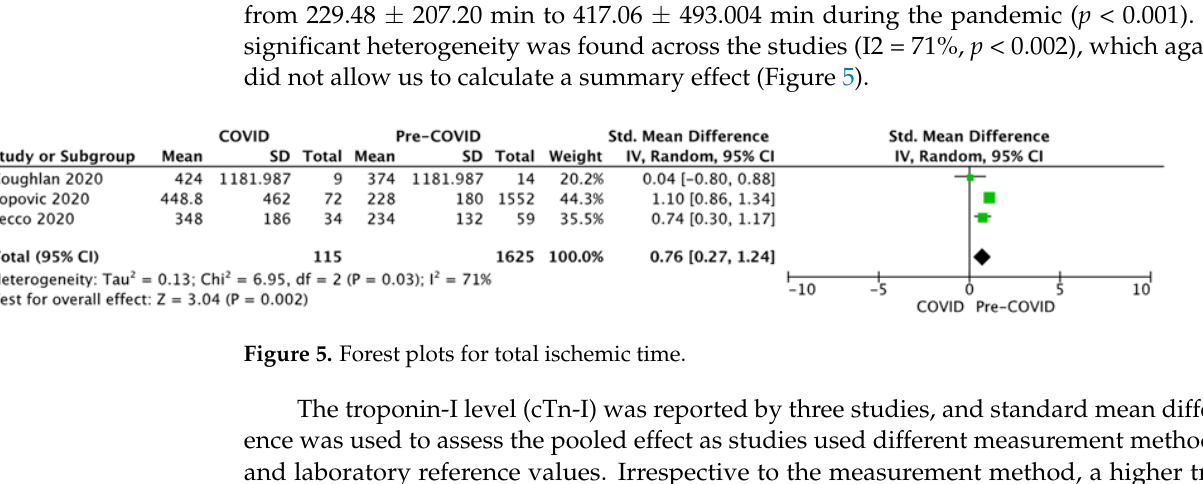
Figure 4. Forest plots for door-to-balloon time.